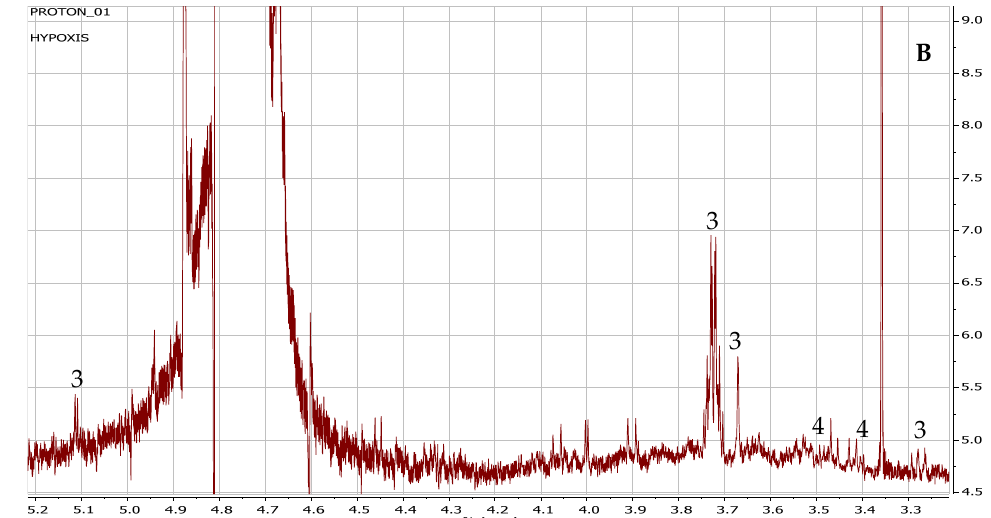
Figure 2. H-NMR spectra showing the metabolite profile of the leachate from Hypoxis hemerocallidea corms. 1 = choline and 2 = succinate ( A ), 3 = lactose and 4 = propylene glycol ( B ). Table 1. Annotation of 1 H-NMR spectral regions and chemical shifts of the four compounds identified from the Hypoxis hemerocallidea